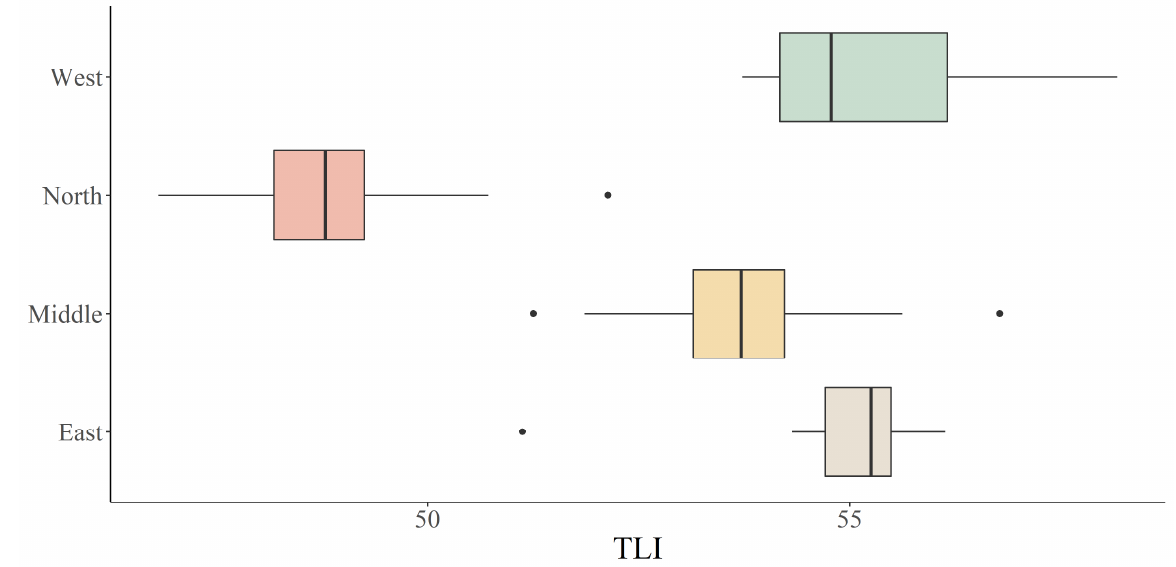
Figure 3. TLI distribution of four lakes in the study area.